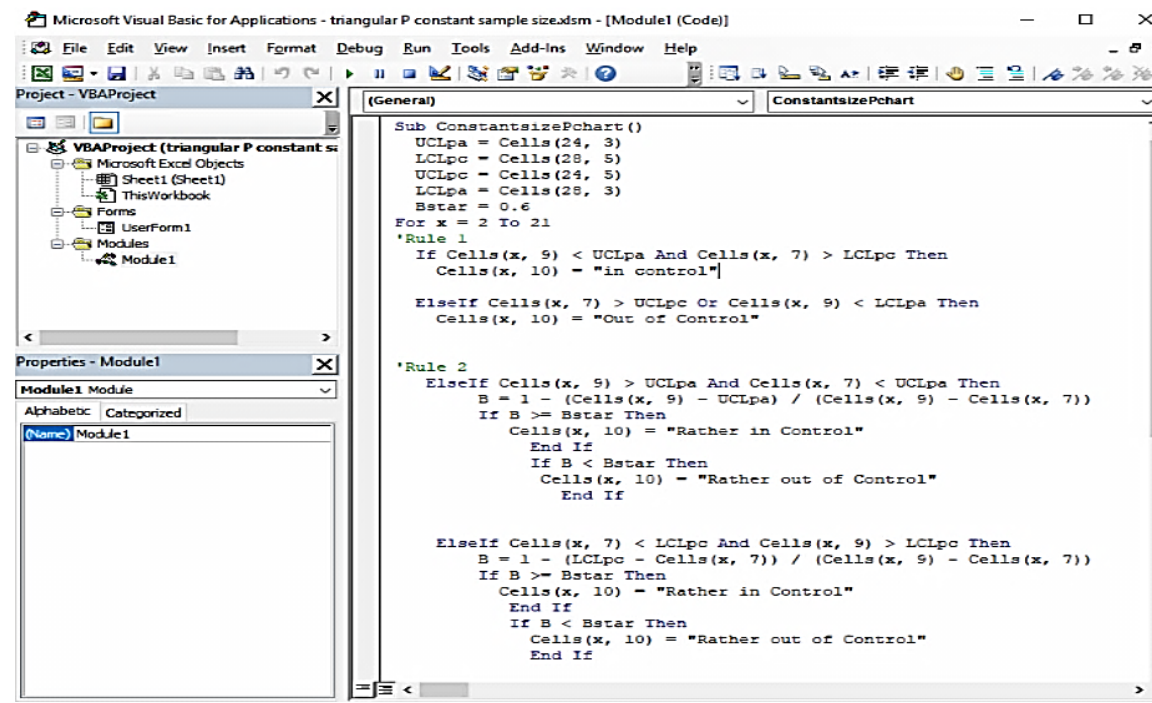
Figure 4. Visual Basic Coding Against the ENTER Command Button.